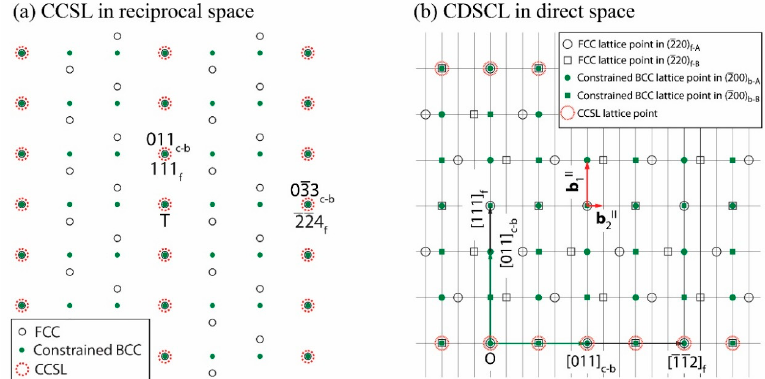
Figure 5. ( a ) The constructed CCSL in reciprocal space and ( b ) the correlated CDSCL in direct space at the ideal N-W OR. The two basic vectors of CDSCL are denoted by b 1II and b 2II . Note that the constrained BCC lattices are colored in green to distinguish themselves from those of natural BCC lattices.